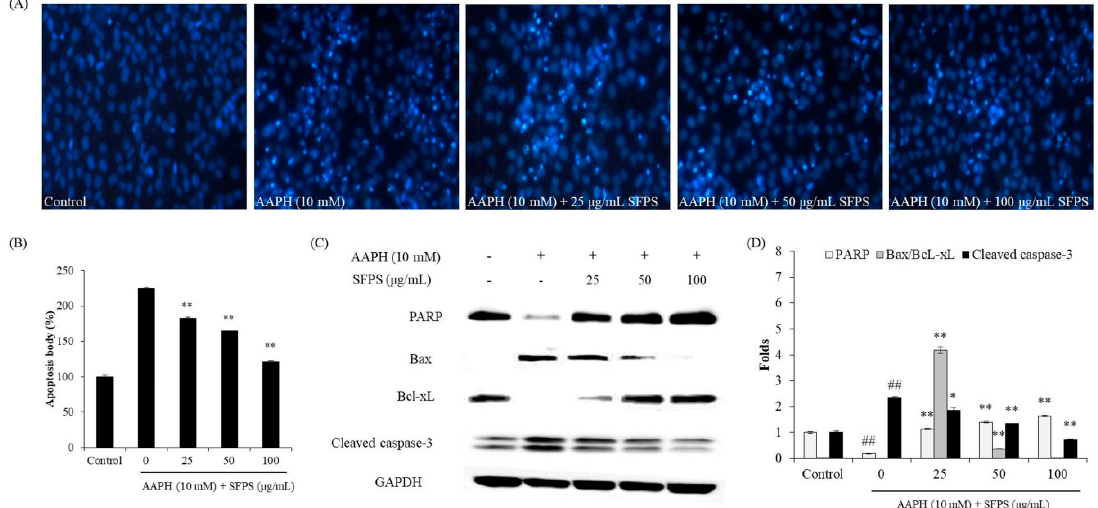
Figure 3. The protective effects of SFPS against AAPH-induced apoptosis in Vero cells. ( A ) Morphology of the Hoechst-stained Vero cells; ( B ) relative apoptotic body level; ( C ) expression levels of apoptosis-related proteins; ( D ) relative amounts of PARP, Bax, Bcl-xL, and cleaved caspase-3. The apoptotic body formation was observed using a fluorescence microscope after Hoechst 33342 staining. The relative amounts of PARP, Bax, Bcl-xL, and cleaved caspase-3 were compared with GAPDH. The relative apoptosis and proteins levels were measured using Image J software. The data are expressed as means ± SE ( n = 3). ** p < 0.01 as compared to the AAPH-treated group and ## p < 0.01 as compared to the control